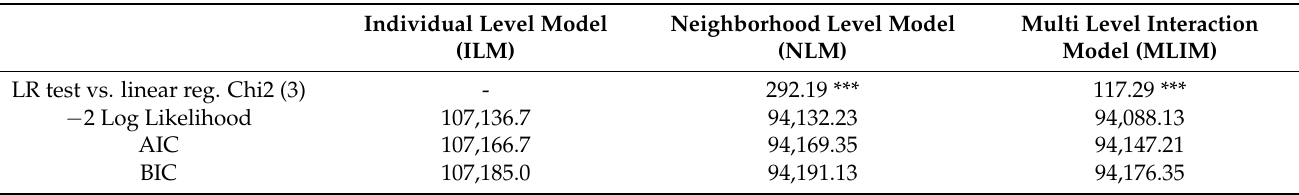
Table 4. Model fits of the empirical